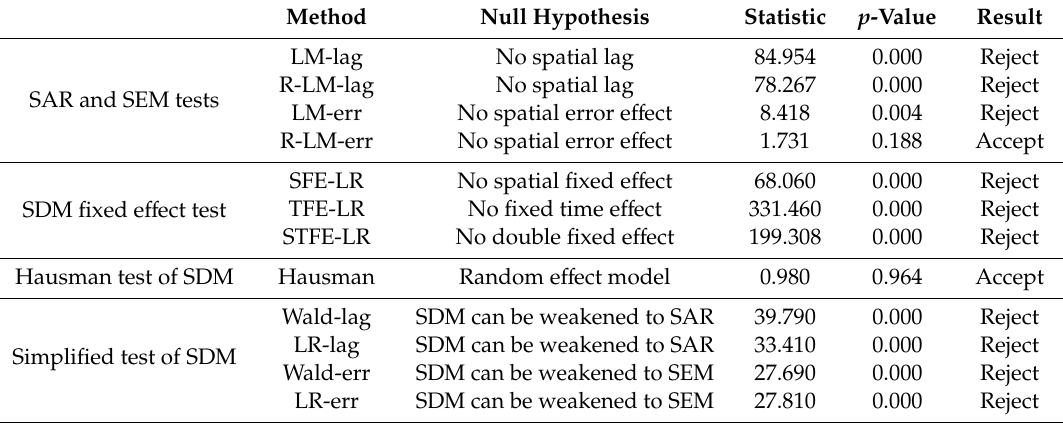
Table 5. Spatial panel data model test (GDP / CO 2 ) under the geospatial matrix. SAR,